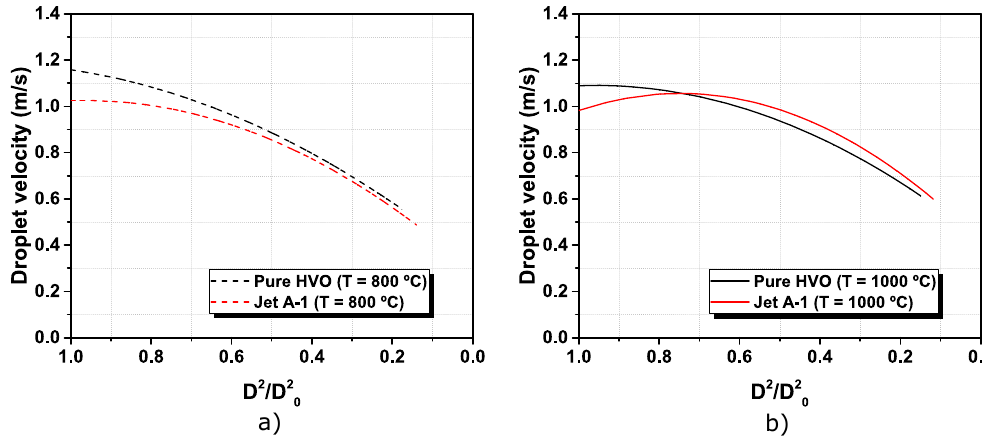
Figure 10. Droplet velocity as a function of the normalized droplet diameter at ( a ) T = 800 ◦ C; ( b ) 1000 ◦ C.